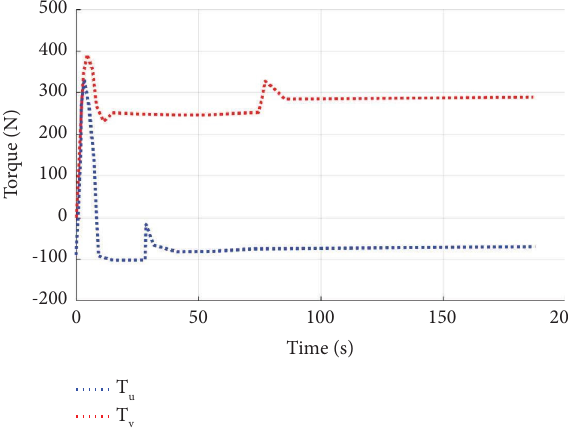
Figure 6: Torque curves with respect to